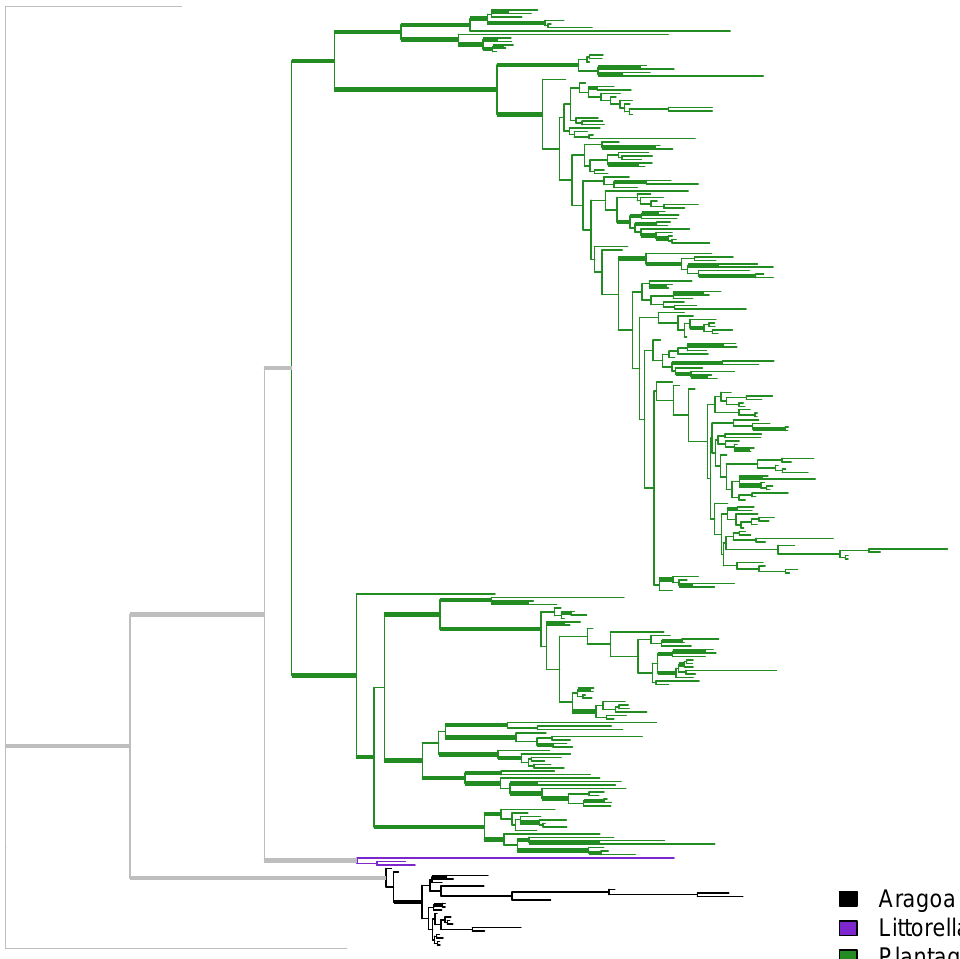
Figure 2. Overview of the MB tree based on the “tall” dataset. Branches with support > 90% are